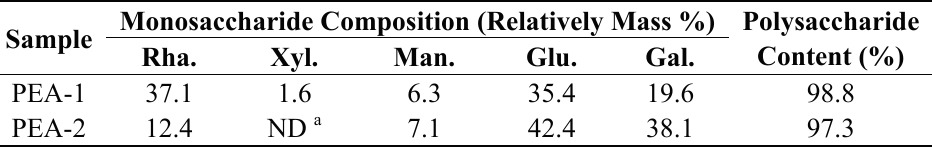
Table 1. Components of monosaccharide of polysaccharides.